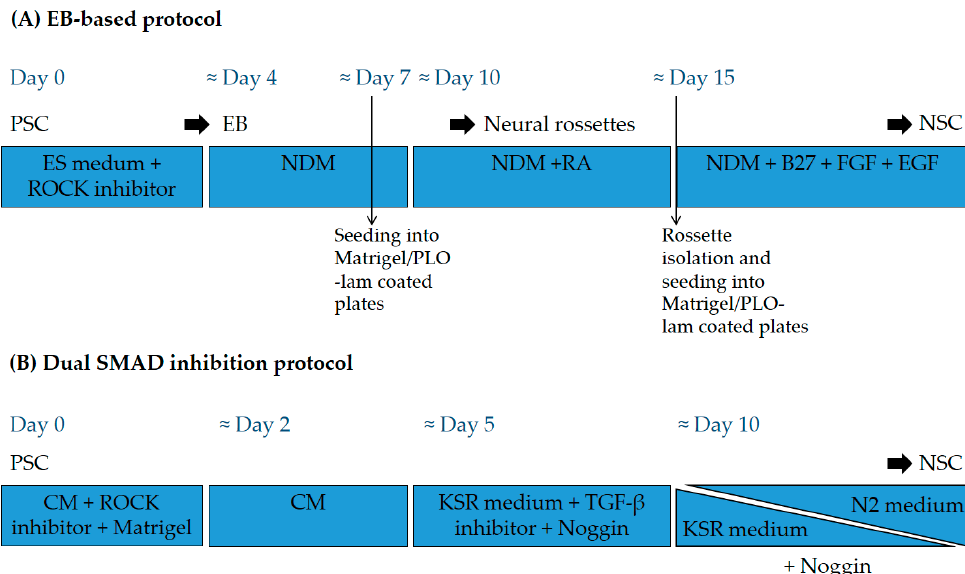
Figure 2. General scheme of differentiation protocols used to produce NSC from PSC. ( A ) Example of an EB-based protocol. Undifferentiated PSC are grown in suspension in embryonic stem (ES) medium with ROCK inhibitor to form embryoid bodies (EB) that are further cultured in neural differentiation medium (NDM) containing N2 supplement, seeded on coated plates, and directed to form neural rosettes containing neuroepithelial cells. ( B ) Example of a dual SMAD inhibition-based protocol. Undifferentiated PSC are plated on Matrigel as single cells in an MEF (mouse embryonic fibroblasts)-conditioned medium (CM) and different inhibitors are added to the cells in the presence of knockout serum (KSR) medium. KSR medium is then gradually replaced by medium with N2